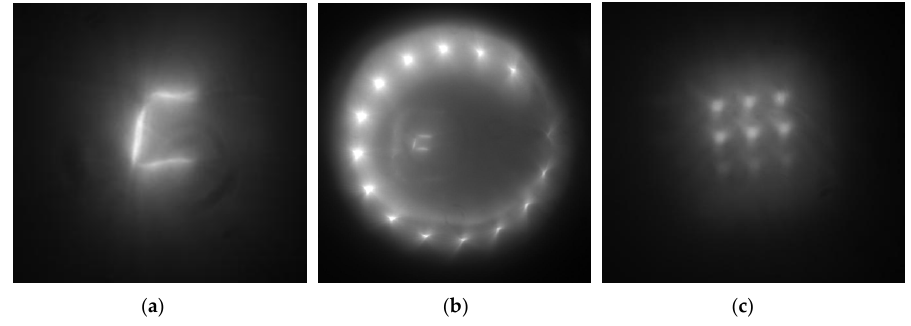
Figure 14. Images of different light sources. ( a ) An incandescent lamp coil; ( b ) White light-emitting diodes (LEDs); ( c ) Color LEDs (upper row, red; middle row, green; and lower row, blue).